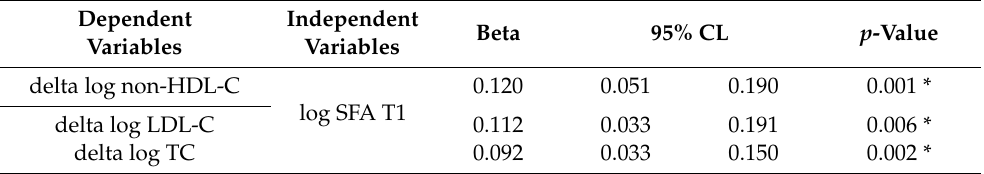
Table 5. The linear regression stepwise, age and sex